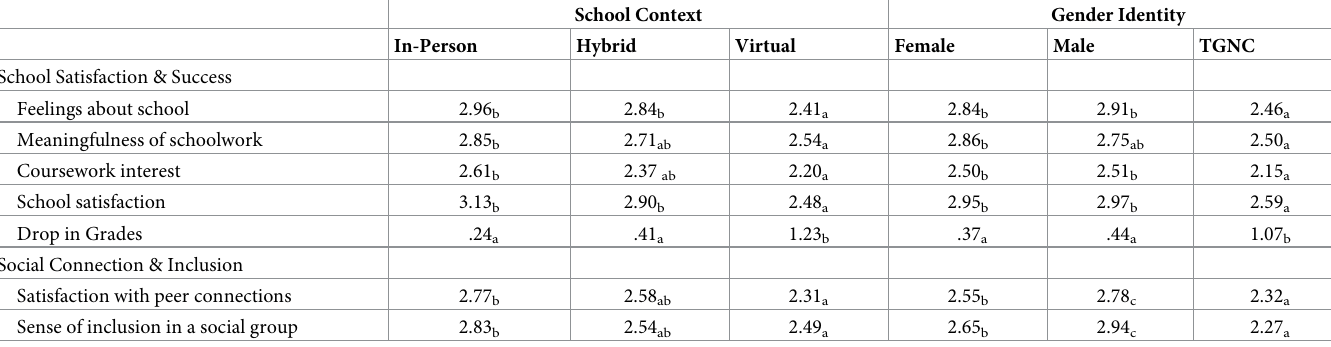
Table 2. School satisfaction and social connection by school context and gender identity.